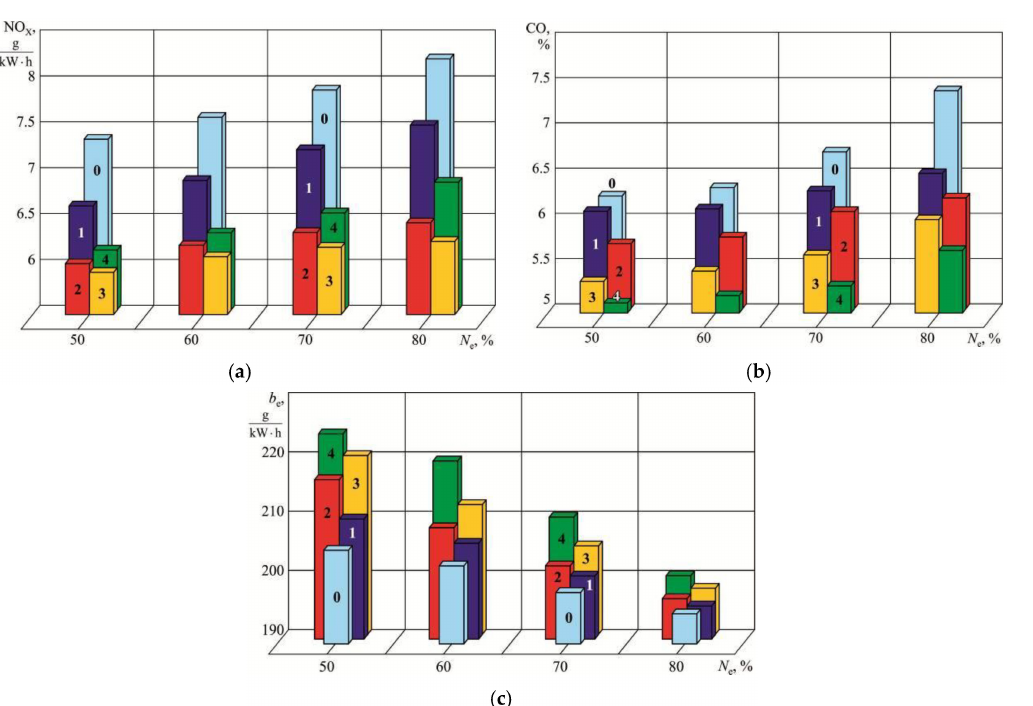
Figure 3. Comparative characteristics 6N165LW Yanmar on the different load when using fuel of different blends: ( a )—emission of nitrogen oxides; ( b )—emission of carbon oxide; ( c )—specific useful fuel consumption; 0—RMA10; 1—RMA10 + 5% biofuel; 2—RMA10 + 10% biofuel; 3—RMA10 + 15% biofuel; 4—RMA10 + 20%